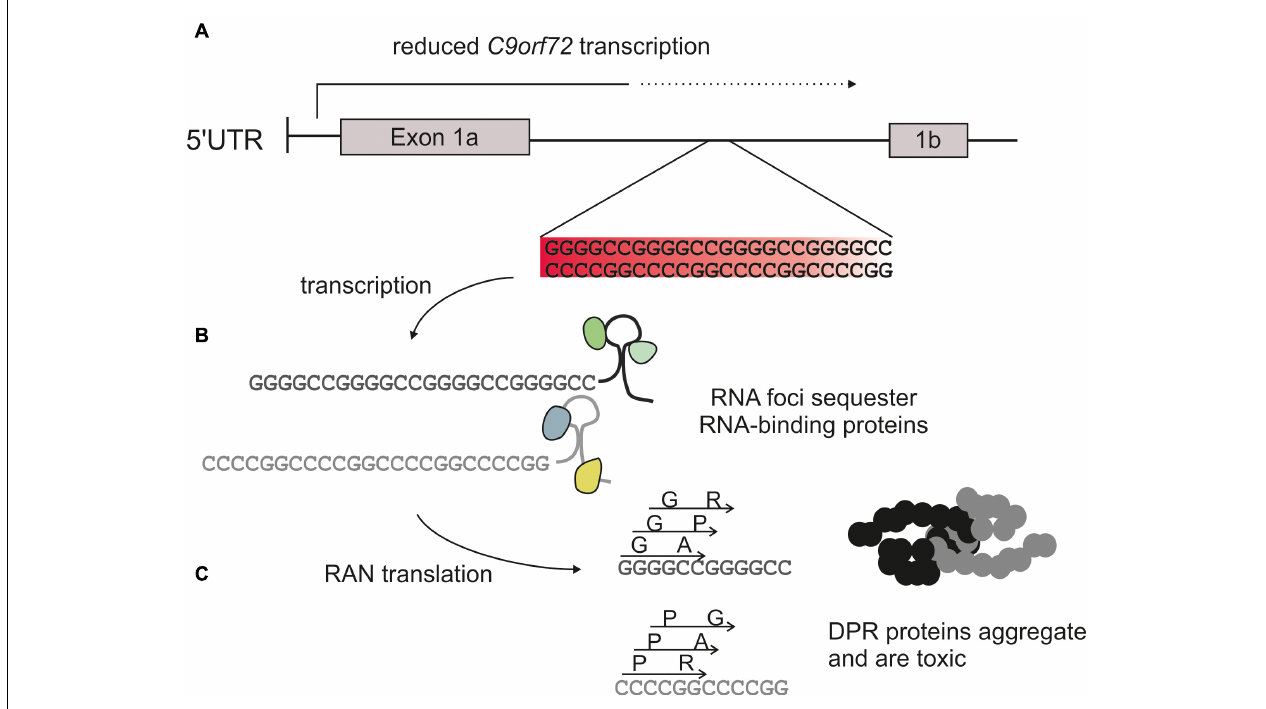
FIGURE 1 | C9orf72 hexanucleotide expansion toxicity. The C9orf72 repeat mutation is an expansion of a GGGGCC sequence usually < 30 repeats in length in healthy controls, to > 1,000 repeats in affected patients. (A) The repeat is located within an intron of the C9orf72 gene. This reduces transcription and therefore production of the endogenous protein (haploinsufficiency). (B) The repeat is transcribed into sense and antisense RNA which can form foci and sequester RNA binding proteins. (C) Repeat RNA is translated via a form of non-canonical translation (repeat-associated non-AUG translation), to produce 5 different dipeptide repeat proteins: glycine-alanine (GA) and glycine-arginine (GR), alanine-proline (AP), and proline-arginine (PR) and glycine-proline (GP). TABLE 1 | Summary of the biochemical properties, abundance, cellular localization, toxicity, and main neuropathological pathways associated with each dipeptide repeat protein (DPR) species. Alanine-proline (AP) Glycine-alanine (GA) Glycine-proline (GP) Glycine-arginine (GR) Proline-arginine